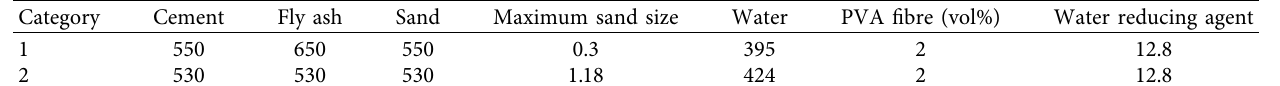
Figure 4: Tensile experiment of SHCC specimens (cm): (a) tensile experiment and (b) SHCC specimens. Table 2: Material mix designs of SHCC (kg/m 3